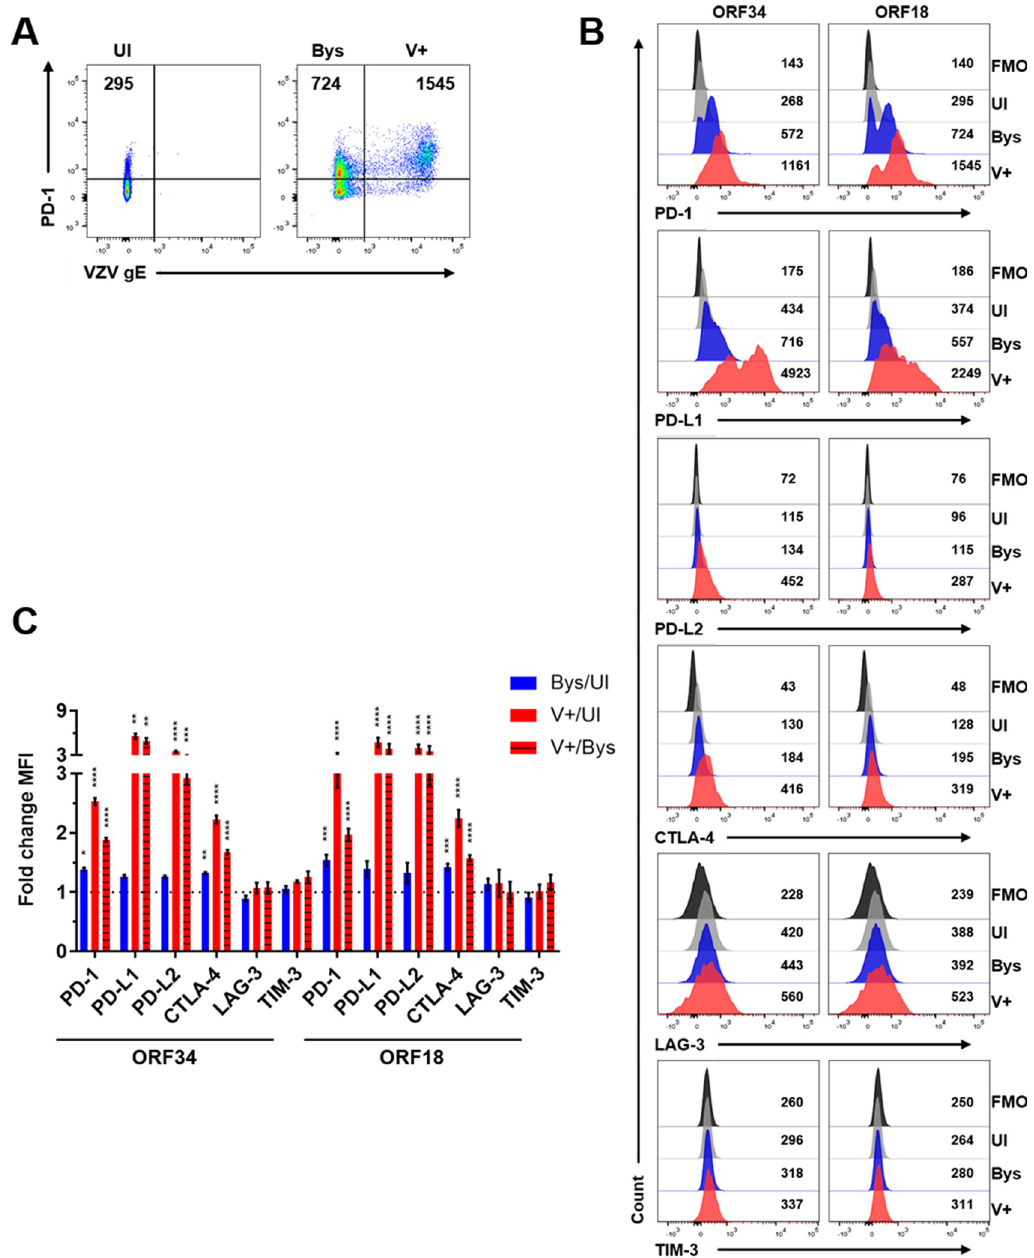
Fig 8. VZV-mediated induction of PD-1, PD-L1, PD-L2 and CTLA-4 expression in VZV ORF34- or ORF18-specific CD8 + T cells. VZV ORF34- or ORF18-specific CD8 + T cells were co-cultured with uninfected- or VZV-infected HFLs/HBVAFs for 48 h, harvested and analyzed for VZV-gE, PD-1, PD-L1, PD-L2, CTLA-4, LAG-3 and TIM-3 expression. Live CD8 + cells are shown. (A) Flow cytometry gating strategy for uninfected (UI), VZV gE-negative bystander (Bys) and VZV gE+ (V+) CD8+ T cells. (B) Representative flow cytometry plots of PD-1, PD-L1, PD-L2, CTLA-4, LAG-3 and TIM-3 MFI expression levels. Black histograms = FMO control, grey histograms = UI, blue histograms = Bys and red histograms = V+ cells. (C) Summary of fold change in MFI in PD-1, PD-L1, PD-L2, CTLA-4, LAG-3 and TIM-3 expression levels in: Bys/UI (blue), V+/UI (red) and V+/Bys (red with black stripes) with respect to ORF34- or ORF18-specific CD8 + T cells. Results are representative of 19, 16 and 12 independent experiments for PD-1/PD-L1, PD-L2/CTLA-4 and LAG-3/TIM-3 expression in VZV ORF18-specific CD8 + T cells, respectively, and of 14, 10 and 6 independent experiments for PD-1/PD-L1, PD-L2/CTLA-4 and LAG-3/TIM-3 expression in VZV ORF34-specific CD8 + T cells, respectively. Bar graphs represent average fold-change in MFI ± SEM. � P < 0.05, �� P < 0.01, ��� P < 0.001, ���� P < 0.0001. Statistical significance was determined using RM one-way ANOVA with the Greenhouse-Geisser correction and Tukey